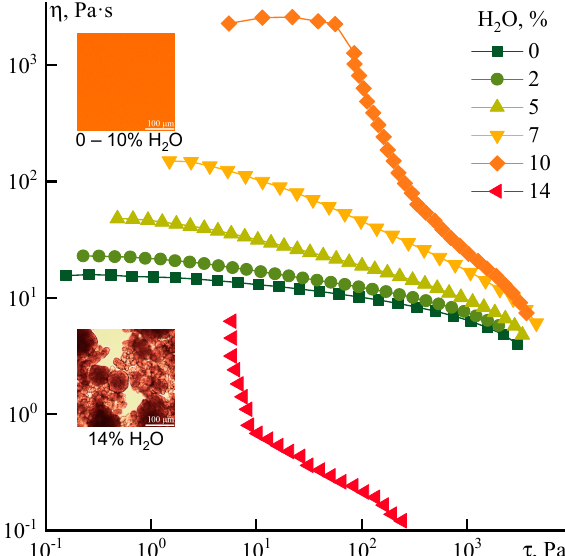
Figure 11. Flow curves of PANI-O solutions with different water content (indicated on the graph). The insets shows a morphology of the systems.